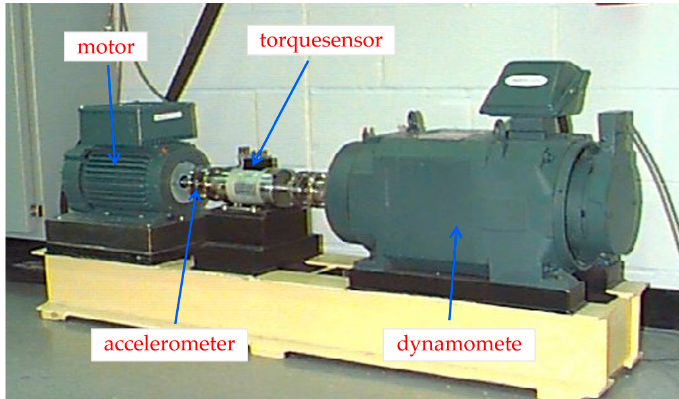
Figure 4. Bearing test platform.